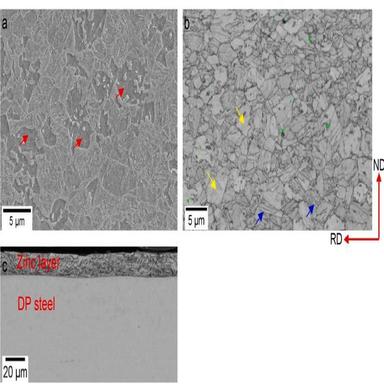
Microstructure of the as-received DP 1180 steel: (a) typical SEM image of microstructure (ferrite is marked by red arrows) of the as-received material; (b) band contrast map (austenite is marked by green color); (c) SEM image of the coated zinc layer on DP steel obtained using backscatter electron (BSE) detector. (For interpretation of the references to color in this figure legend, the reader is referred to the Web version of this article.)